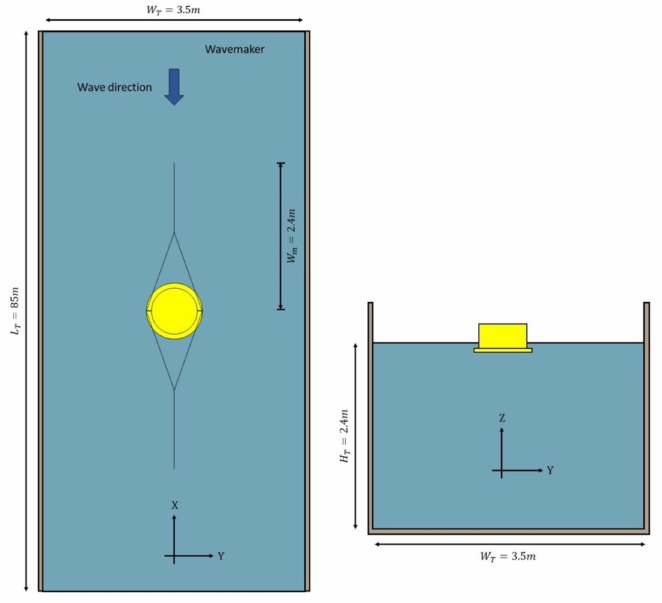
Figure 3. Top and front views of the wave tests setup in the towing tank.